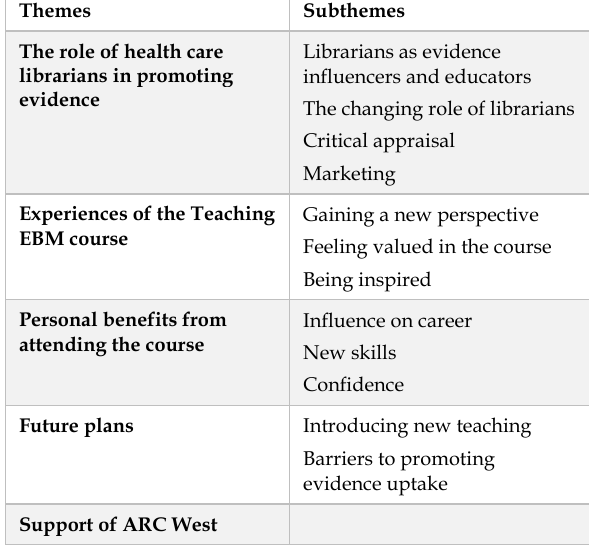
Table 1. Summary of themes